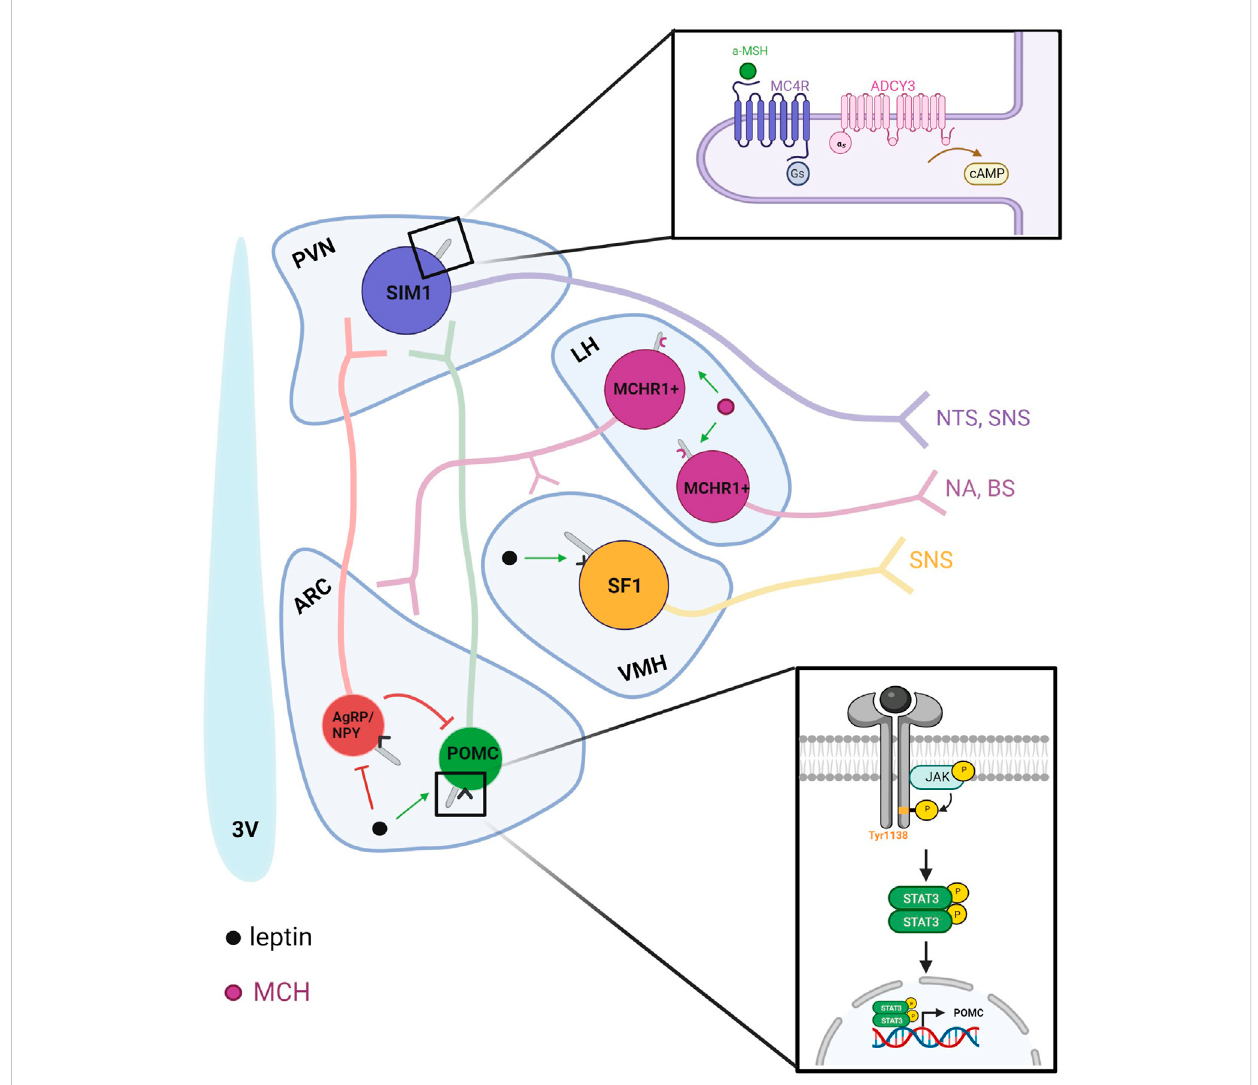
FIGURE 2 Ciliary-speci fi c signaling in the hypothalamus integrates peripheral nutrient signals with neuronal output and connectivity. Leptin released from the periphery isdetectedbyprimaryciliainthehypothalamus. Theleptin-melanocortinpathwaybeginsintheARCwiththestimulationofPOMC-expressing neurons and the inhibition of AgRP/NPY-expressing neurons. POMC-expressing neurons release α -MSH, which then binds to MC4R to increase satiety. Within thehypothalamus, MCH also regulatesenergyhomeostasisas anorexigenic peptide that isupregulated during fasted states to increase food intake. In addition to the zona incerta, MCH is expressed in the lateral hypothalamus and sends projections locally to the ARC and VMH and to regions such as the brain stem and nucleus accumbens to modulate autonomic and hedonic aspects of food